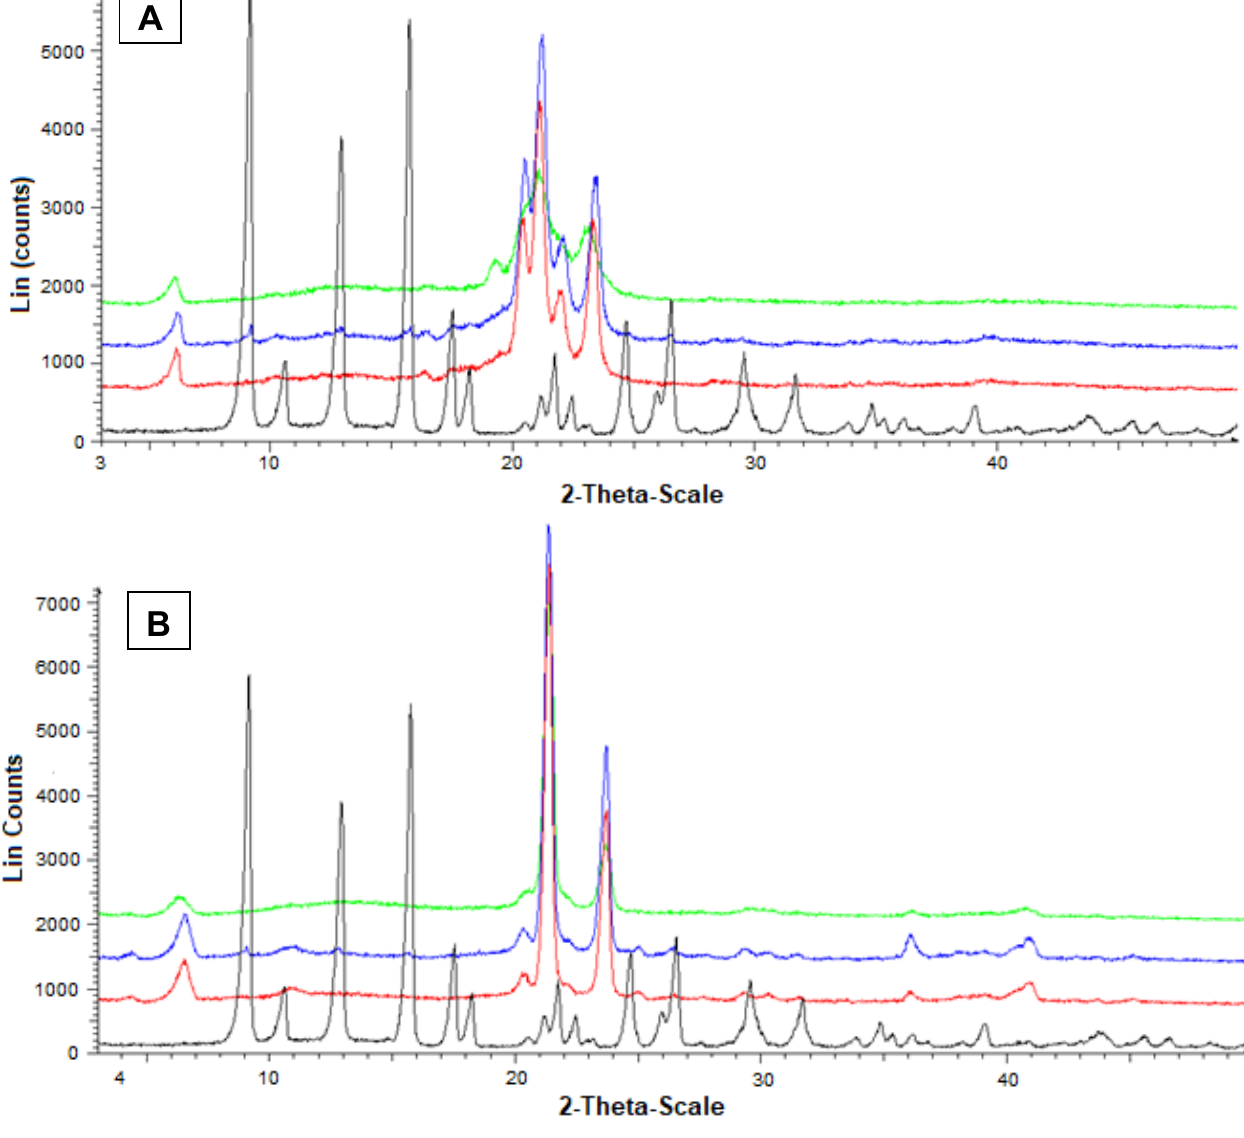
Figure 6. Powder X-ray diffraction patterns of Fer (black), tristearin (red) ( A ) Stearic acid (red) ( B ) Drug lipid mixtures (blue) and loaded SLMs (green). ( A ) Diffraction patterns referred to tristearin and Fer; ( B ) Diffraction patterns referred to stearic acid and Fer.